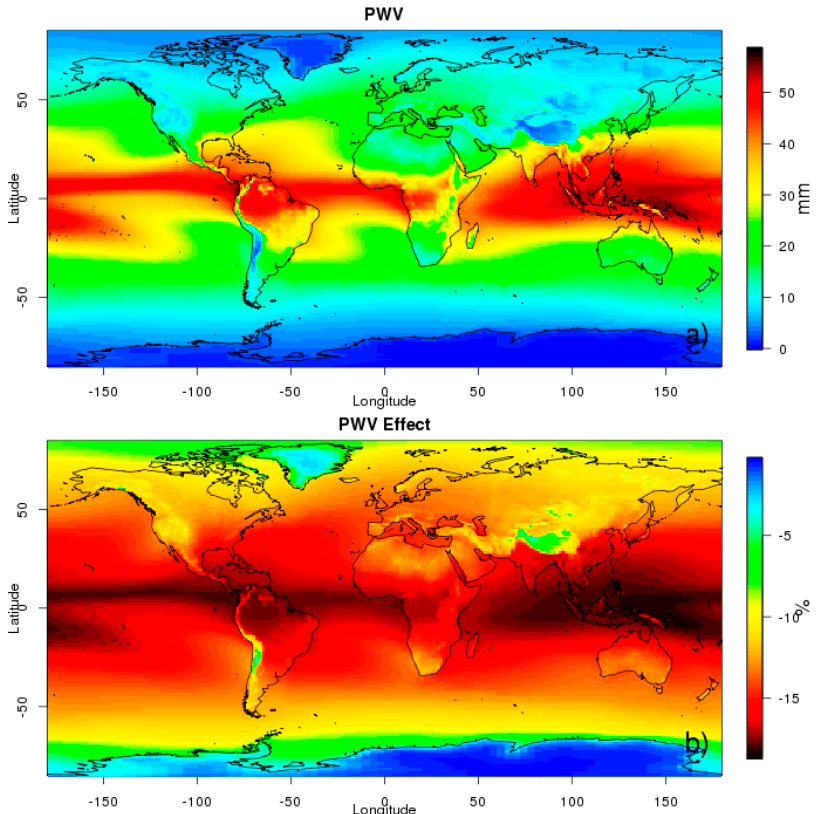
Figure 6. Global spatial distribution of averaged values of ( a ) PWV and ( b ) PWV effect during the period 2000–2019. PWV effect is quantified by Equation (3) and refers to the effects on downwelling SW irradiance reaching the Earth’s surface under different values of PWV.